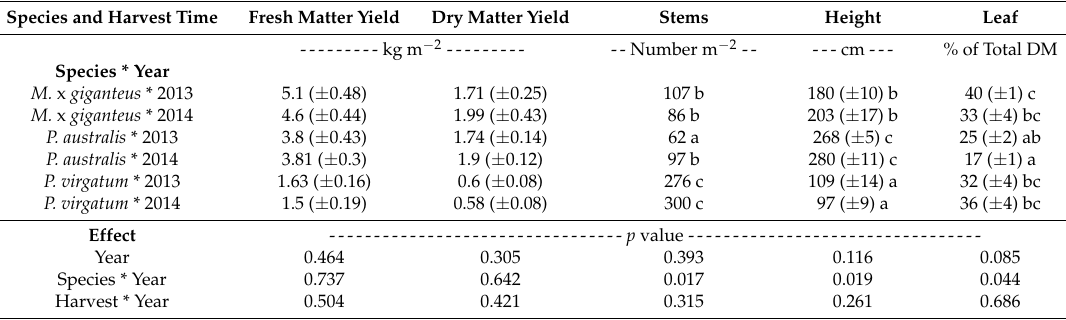
Table 3. Mean ( ± standard error) plant characteristics for year by species interactions for Phragmites australis, Panicum virgatum, and Miscanthus x giganteus ‘Nagara’, at three sites in Southwestern Ontario, Canada, harvested in 2013 and 2014 ( n = 6). Means followed by the same letter in each column are not significantly different according to Tukey’s range test ( p > 0.05). Other results of